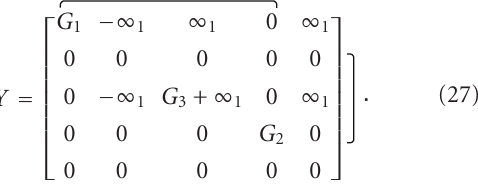
Table 3: Types of conveyors used in the lowpass filter of Figure 7(a). Circuit